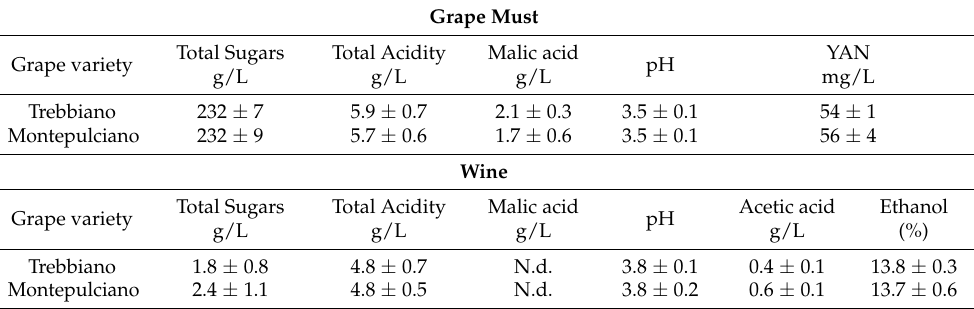
Table 1. Main chemical parameters of grape must and wine of Trebbiano and Montepulciano involved in this work. Total acidity is expressed as g/L of tartaric acid, YAN means the nitrogen promptly assimilable from yeast. N.d.: not